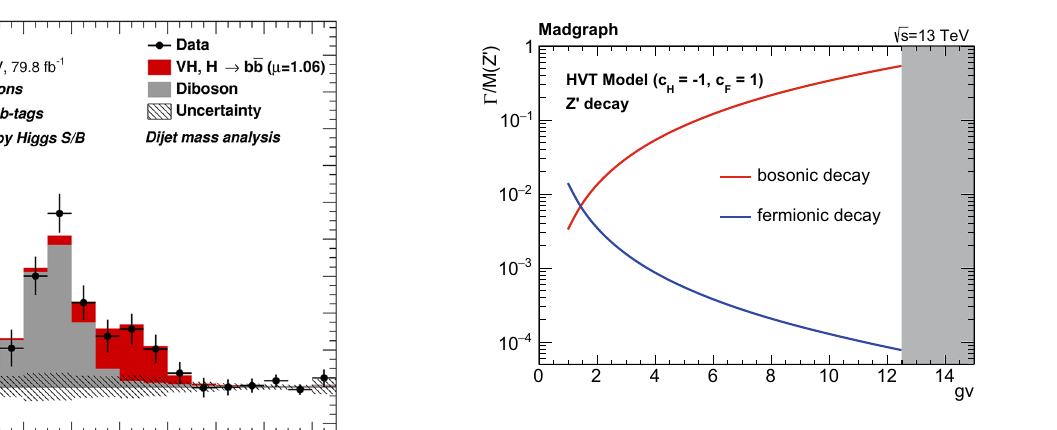
Fig. 4 Heavy resonance width for bosonic and fermionic decays as a function of the g V coupling